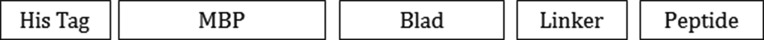
Production of the recombinant peptide-fusion proteins in E.coli. Design of both peptide-fusion proteins.